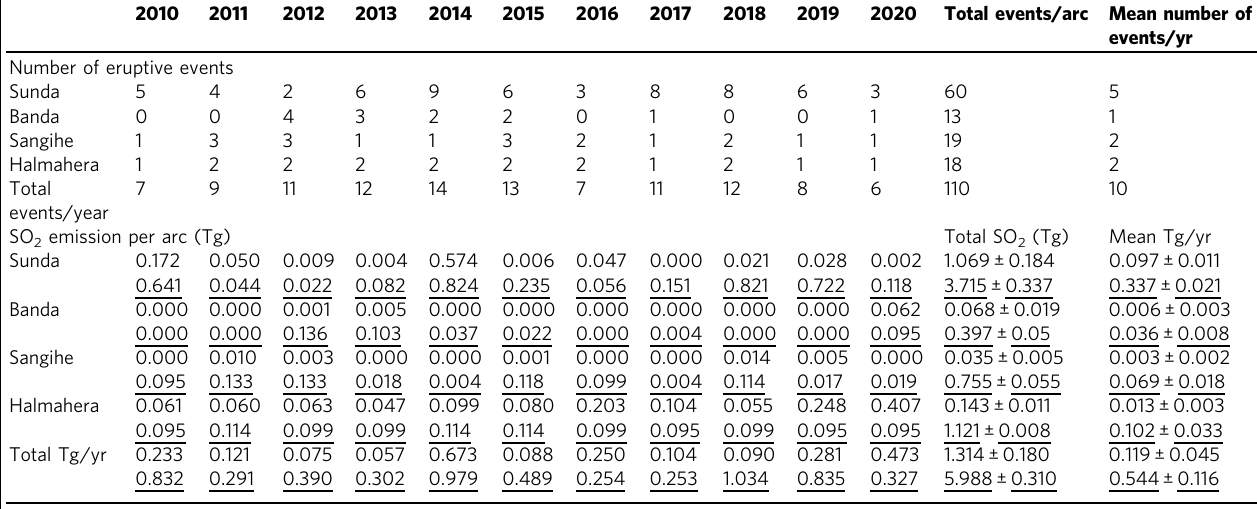
Underlined values are those obtained from